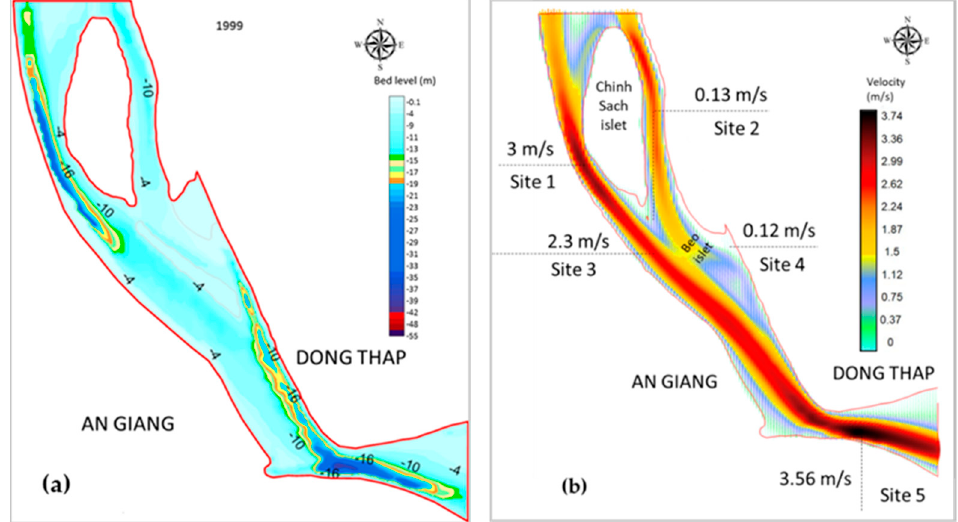
Figure 12. The initial bathymetry of the study area ( a ) and the velocity field of the peaking flood at 21:00 on 29 September 2002 ( b ).